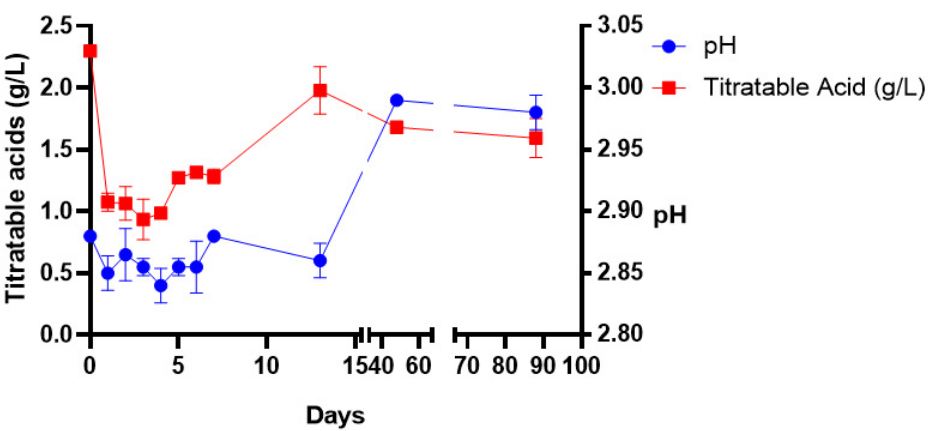
Figure 2. Change in total ethanol and sugars in cactus pear wine during fermentation and storage process.